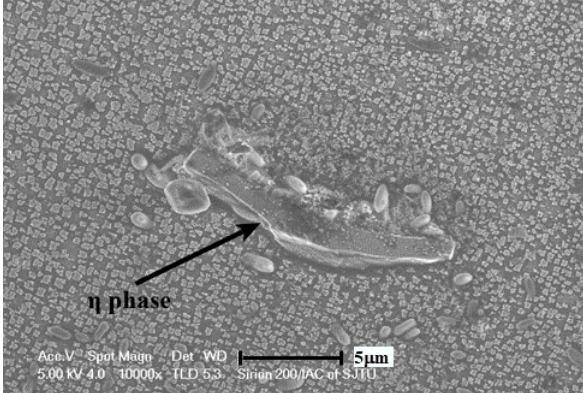
Figure 7. Carbide phase in the solidified DSC sample with cooling rate of 20 K/min. ( a ) is the SEM morphology of carbide. ( b ) is the EDS spectrum of the spot of carbide in the DSC sample, according to the white cross in blue background. The inset in top right corner is the component ratio in weight and atom.